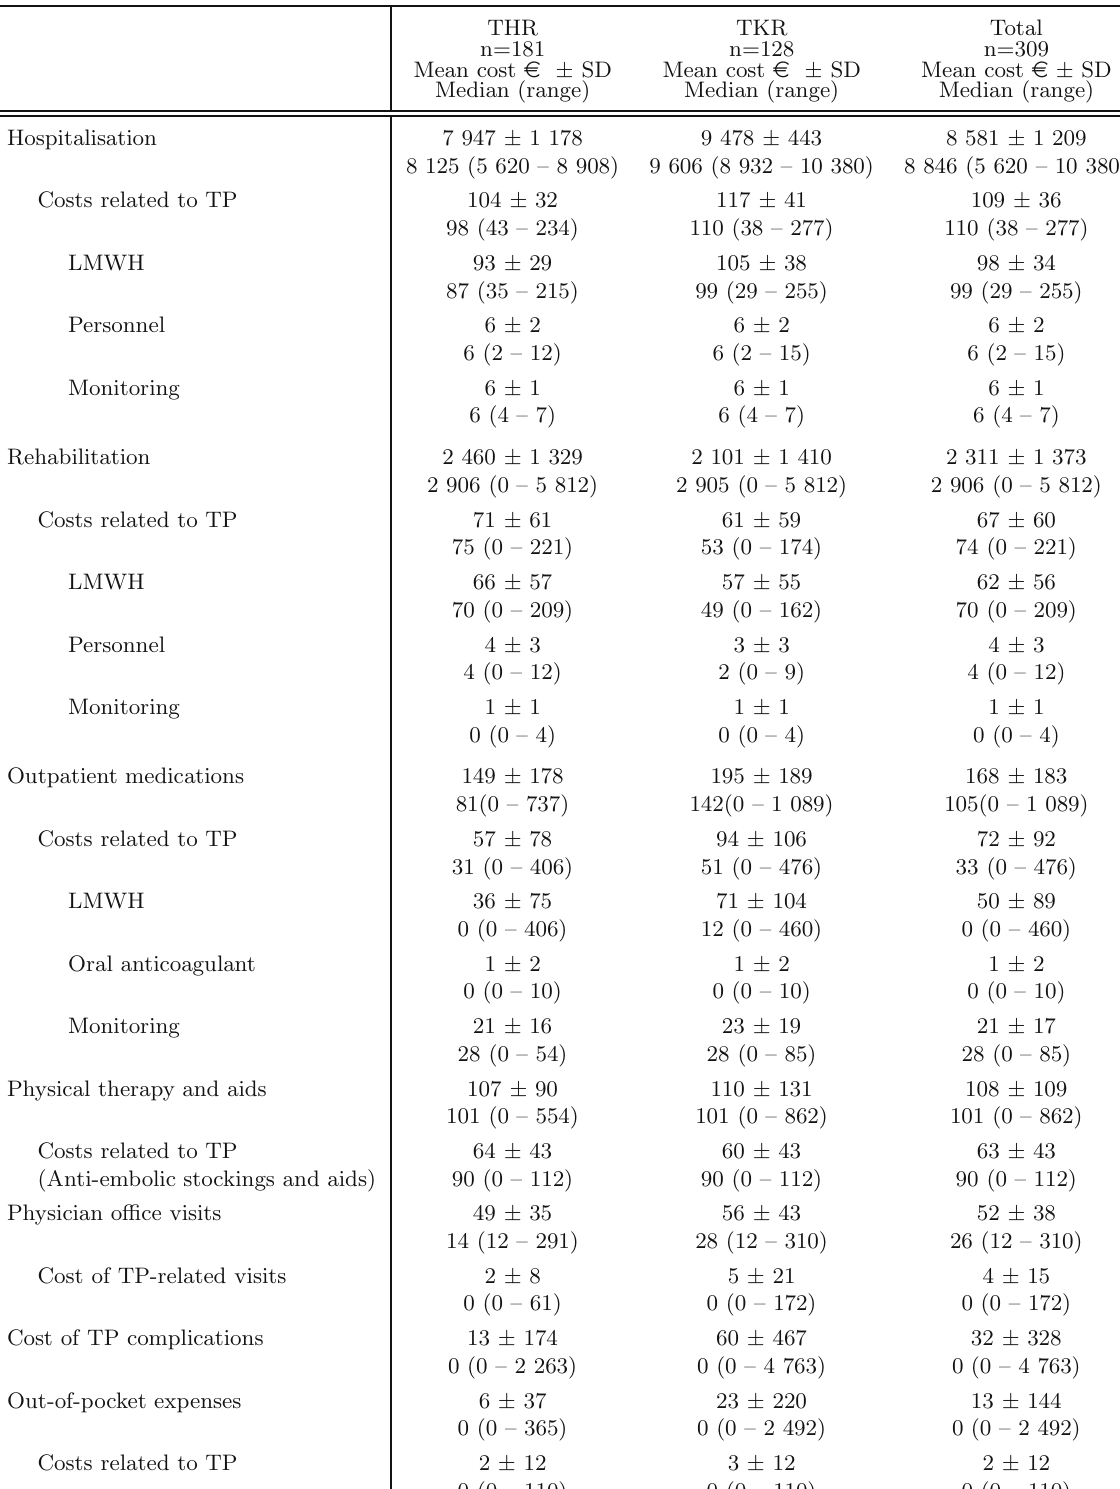
Table 5 Costs in hip (THR) and knee (TKR) replacement surgery, including costs relating to thrombosis prophylaxis